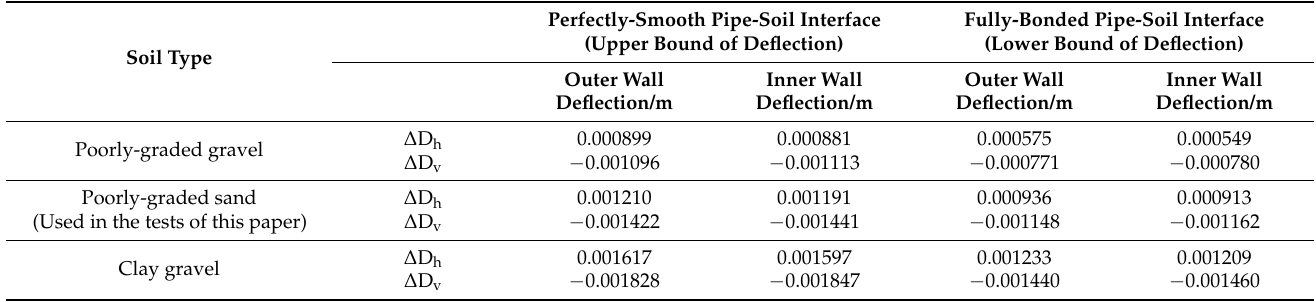
Table 5. The deflection of the buried HDPE pipe in different backfill materials under 280 kPa vertical pressure.